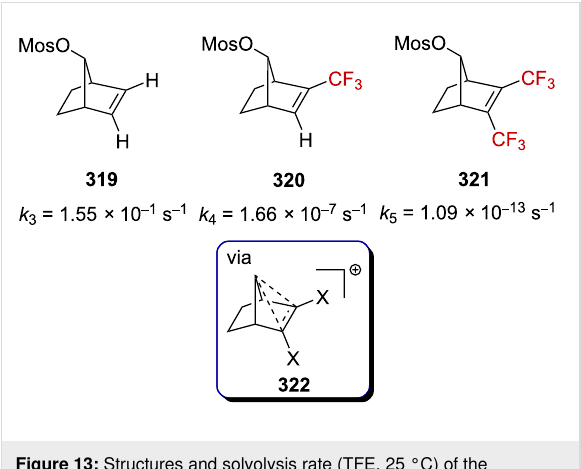
Figure 13: Structures and solvolysis rate (TFE, 25 °C) of the sulfonates 319 – 321 . Mos = p -MeOC 6 H 4 SO 2 .